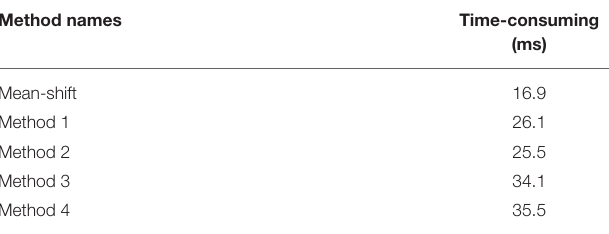
TABLE 2 | Time consumed by each method in single tracking tasks.